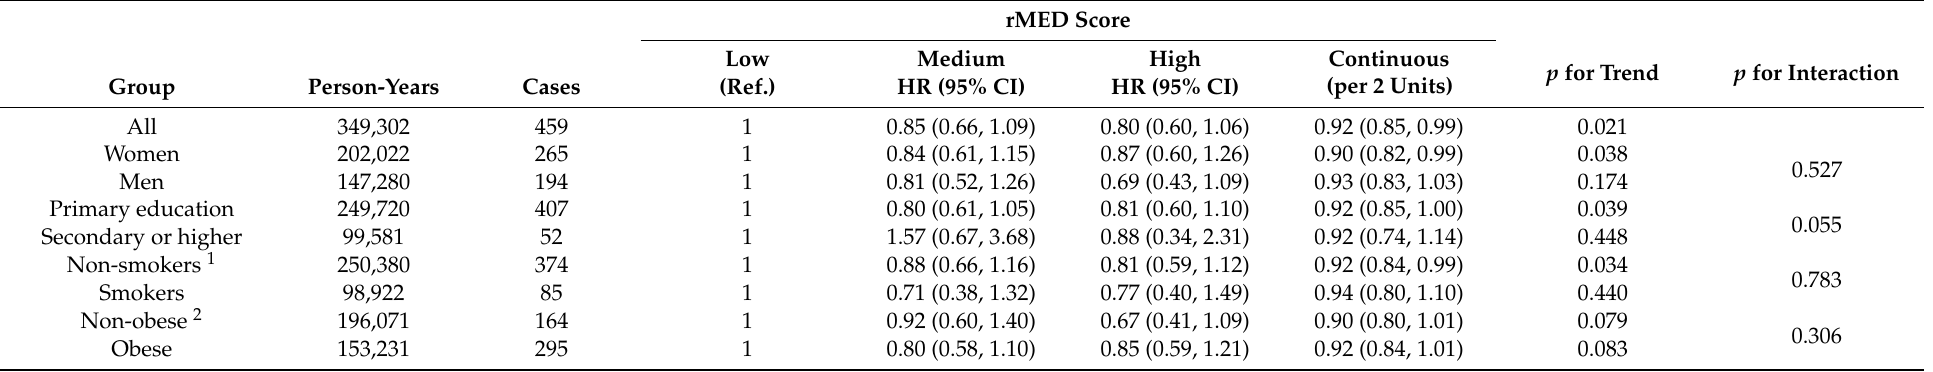
Table 4. Hazard ratios of dementia by levels of adherence to the Mediterranean Diet score (rMED), stratified by selected variables in participants from the EPIC-Spain Dementia Cohort study ( N =